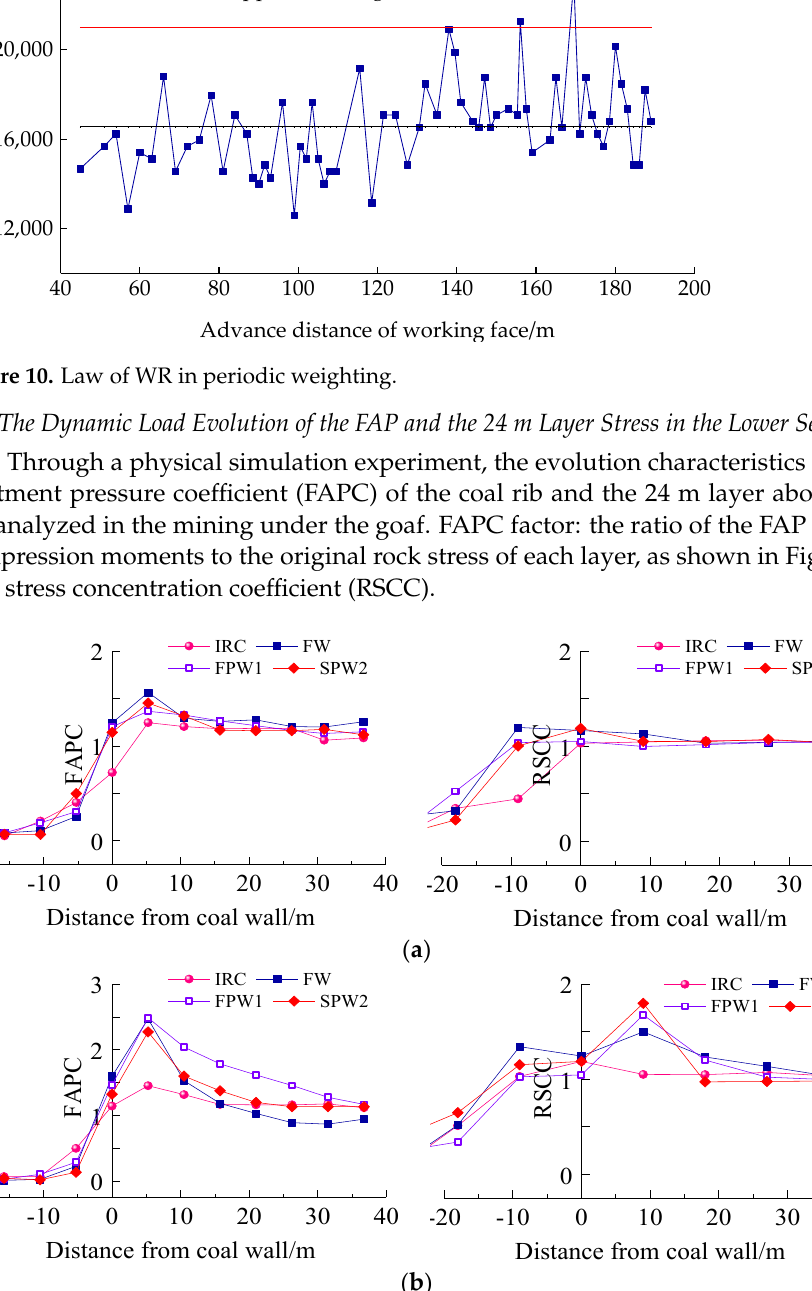
( b ) Figure 9. Law of period weighting under the goaf: ( a ) FPW4. ( b ) FPW5. By analyzing the physical experiment of 22410 working face mining under the goaf